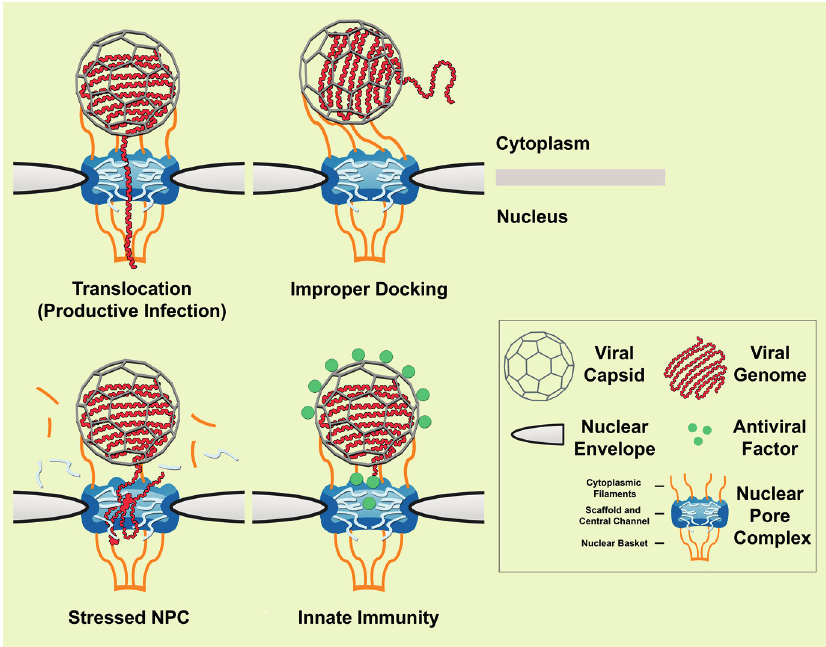
Figure 2. Possible ways that nuclear pore complexes inhibit viruses during cell